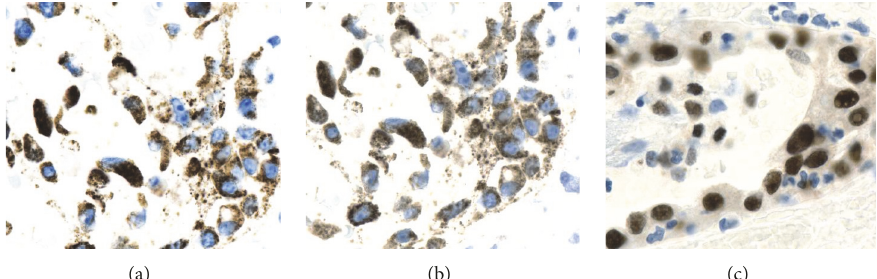
Figure 3: Immunohistochemical profile. Tumor cells are immunoreactive for AMACR, cytoplasmic staining (a), Napsin-A, cytoplasmic staining (b), and PAX-8, nuclear staining (c)